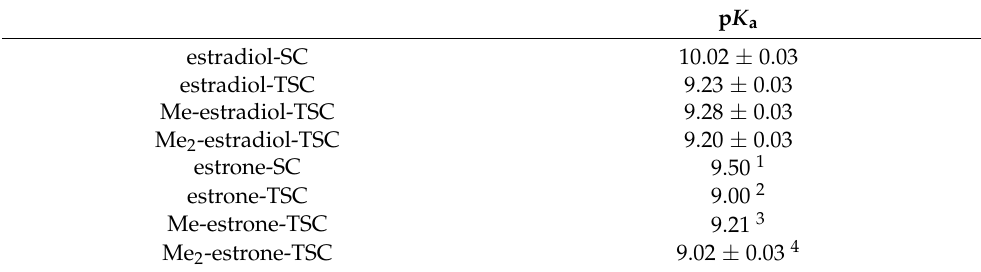
Table 1. p K a values of the studied compounds determined by UV–vis spectrophotometric titrations in 30% ( v/v ) DMSO/H 2 O ( T = 25 ◦ C, I = 0.10 M